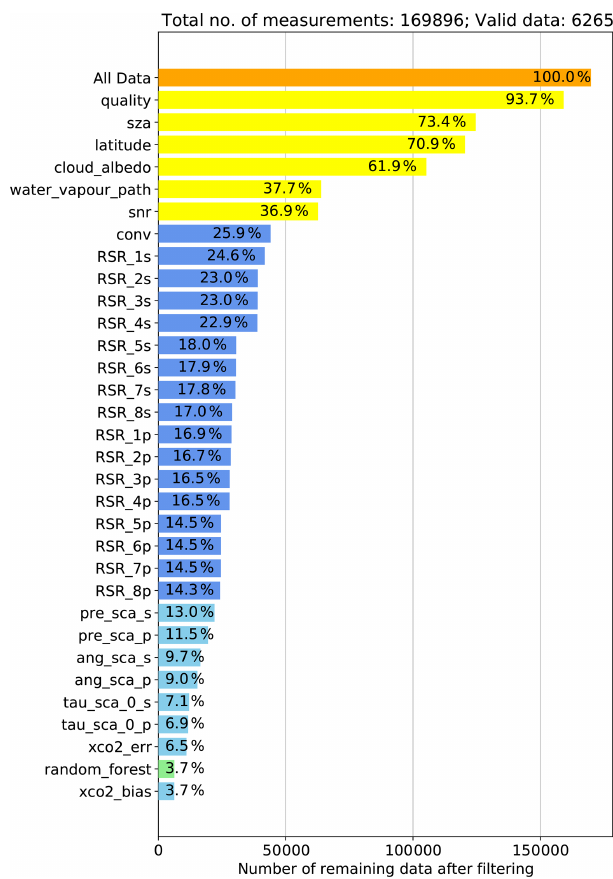
Figure 3. Same as Fig. 2, but for GOSAT-2.